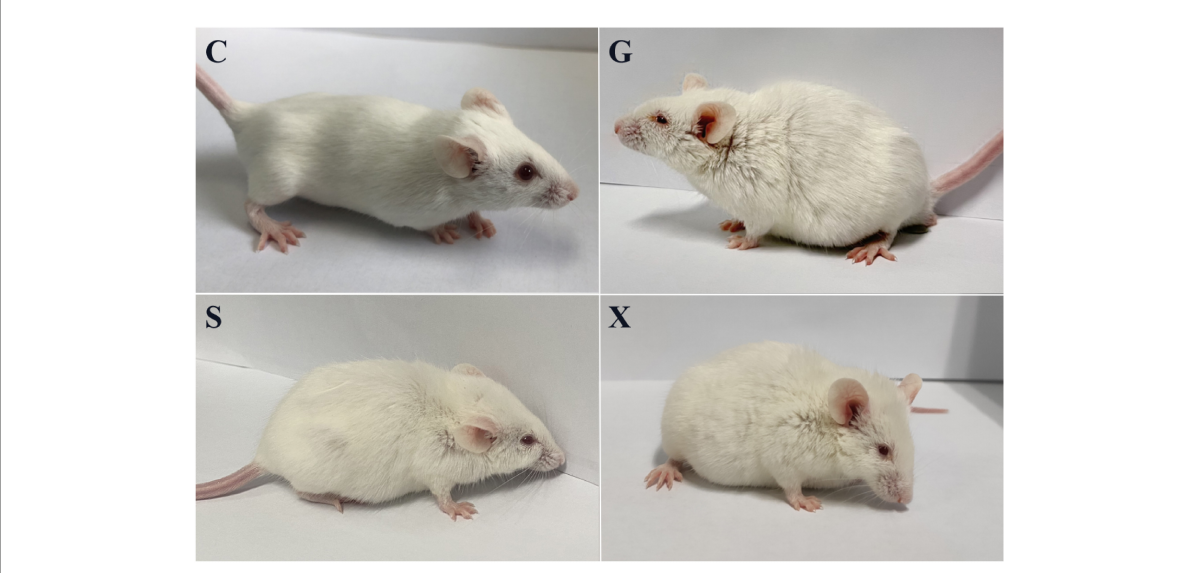
FIGURE2 Pictures of mice with reactivation of Toxoplasma gondii infection. C: no T. gondii + DEX + PBS; G: 3 T. gondii cysts + DEX + PBS; S: 3 T. gondii cysts + DEX + koumiss; X: 3 T. gondii cysts + DEX + mare’s milk.